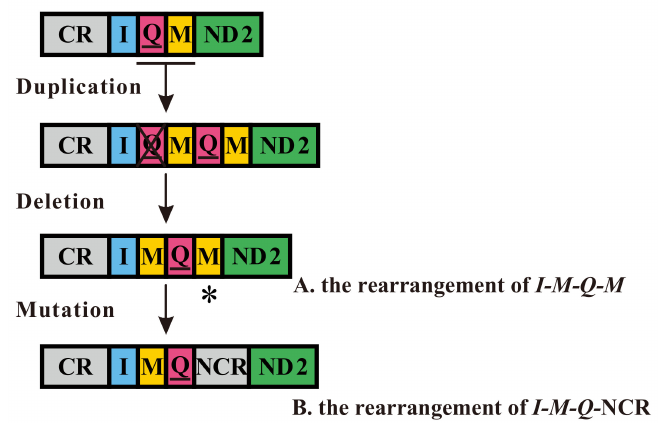
Figure 2. Proposed mechanism of gene rearrangements in the seventeen Heptageniidae mitogenomes. Gene sizes are not drawn to scale. Genes encoded by the L-strand are underlined, whereas those without underline are encoded on the H-strand. Different colored boxes represent different genes. The remaining genes and gene orders that were identical to the ancestral insect are left out. Horizontal lines, asterisk symbols, and crossed-out symbols represent gene duplications, gene mutations, and gene deletions, respectively. ( A ) Rearrangement of I-M-Q-M ; ( B ) rearrangement of I-M-Q-